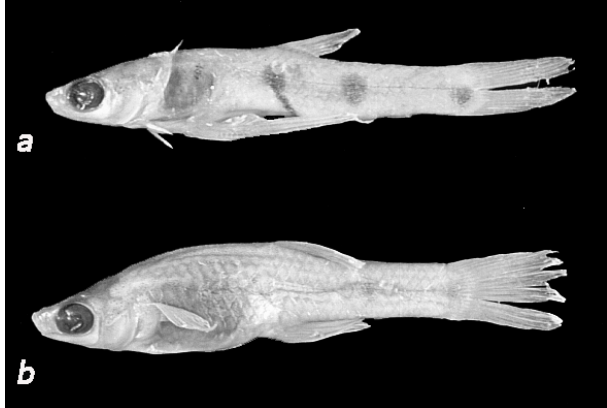
Fig. 4. Cnesterodon raddai . UMMZ 207503, small stream at bridge on dirt road to Ayolas, Misiones, Paraguay: (a) male, 16.9 mm SL; (b) female, 23.2 mm SL. ing to dorsal and ventral profiles ( vs . dark bars of body very elongate reaching dorsal and ventral profiles, covering more than four scales in a transverse row). The absence of small scales covering lateral and ventral region of body below pec- toral fin in adult females and the pointed snout distinguishes C . decemmaculatus from C . brevirostratus . Cnesterodon